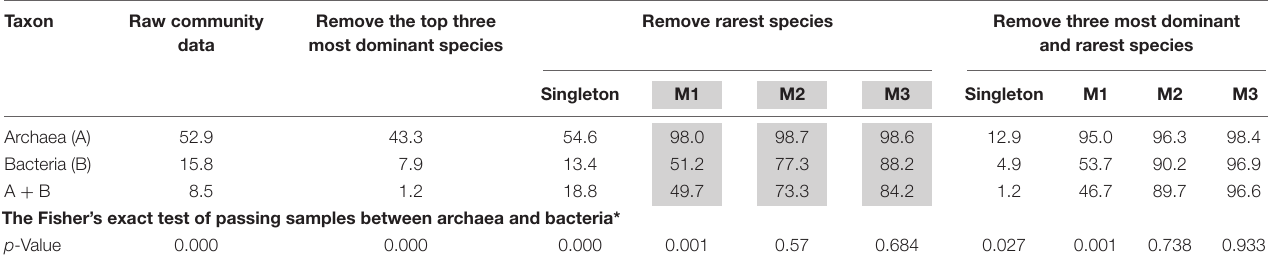
TABLE 1 | The percentages (%) of hot-spring-microbiome community samples that passed the neutrality test with four different test schemes [ p -value adjusted with standard FDR control (Benjamini and Hochberg, 1995)]. Taxon Raw community